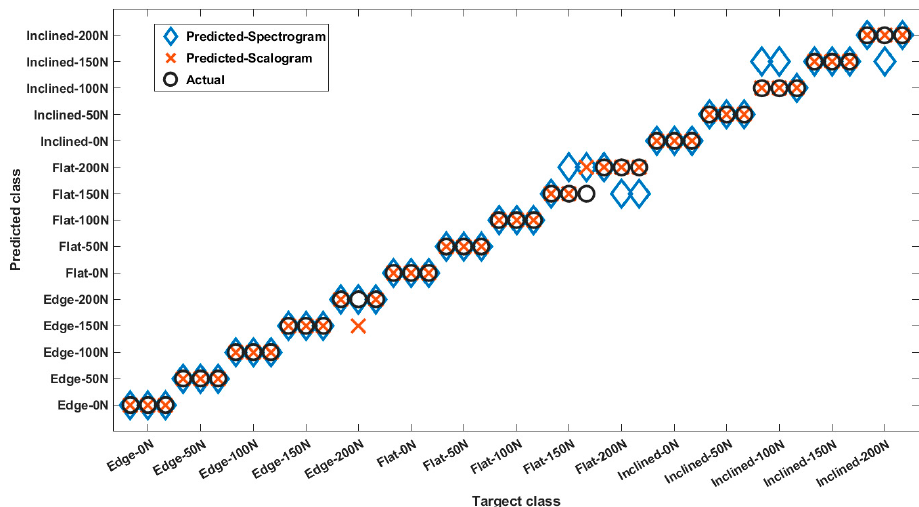
Figure 10. Classification results for solid parts at different loading conditions.